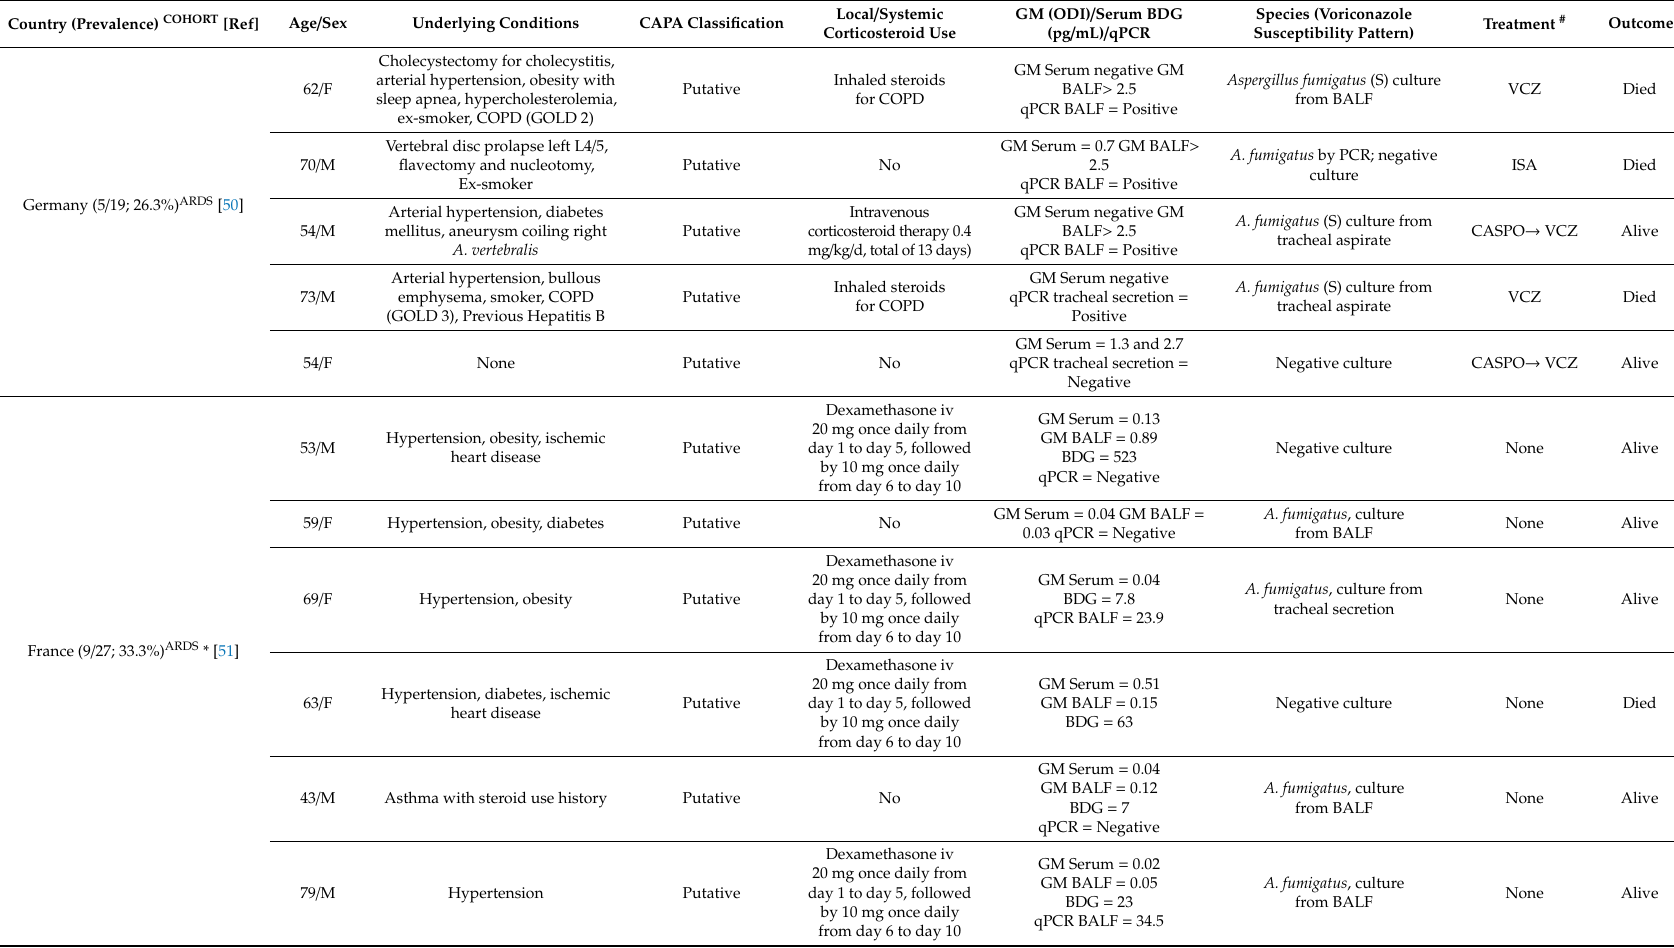
Table 1. Clinical characteristics of COVID-19 patients with pulmonary aspergillosis published before 10 June